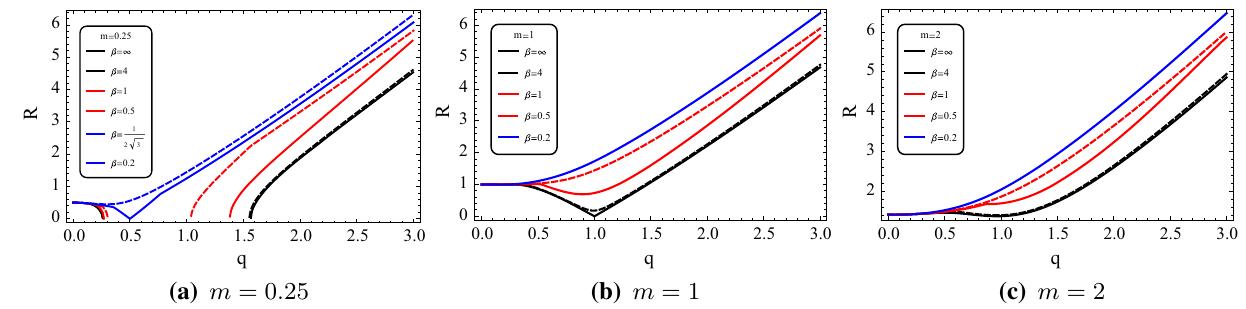
Fig. 5 The distance R between inner and outer horizons for m = 0 . 25, 1 and 2 for nonlinearly charged BTZ black